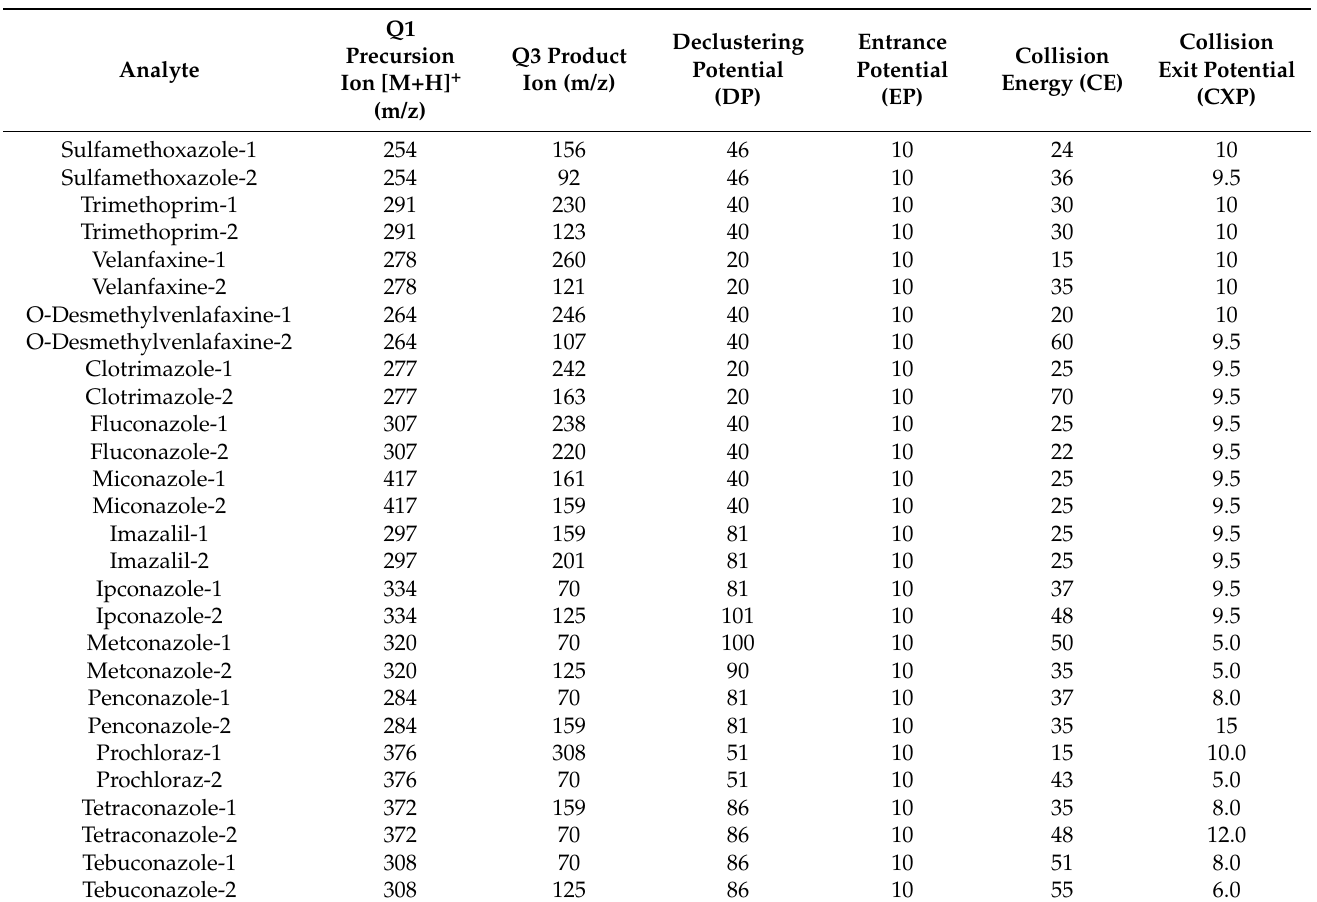
Table 2. Analyte, m/z transitions and operating parameters by ESI-MS MRM(+)